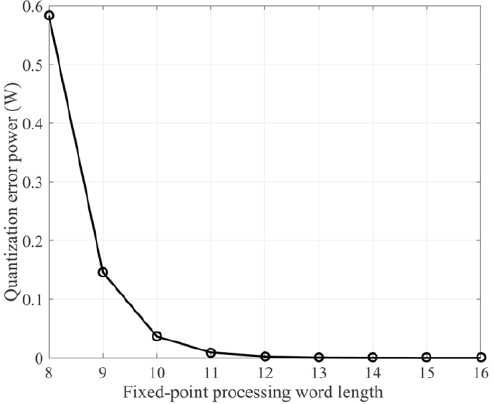
Figure 3. Quantization error power for different fixed-point processing word lengths.